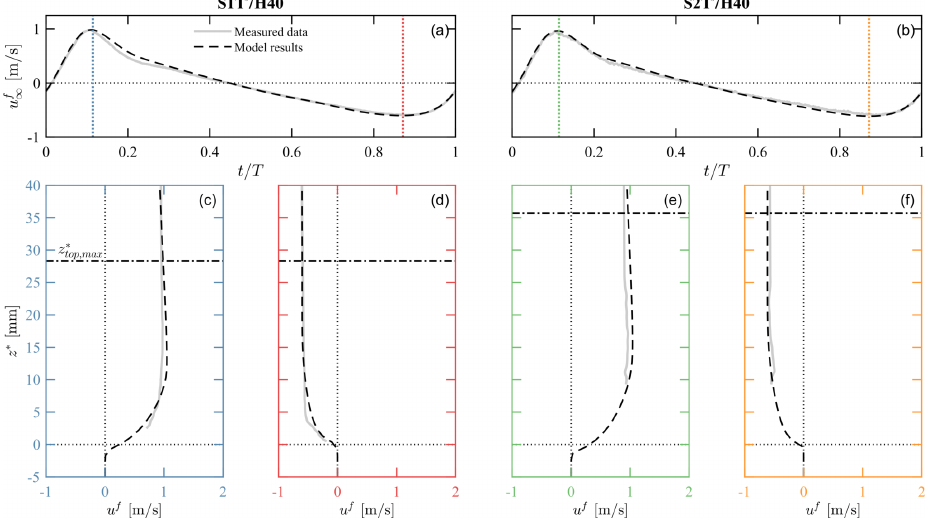
Figure 6. Time series of measured (gray solid curves) and modeled (black dashed curves) free stream velocity, u f ∞ ( t / T ) , for ( a ) S1T7H40 and ( b ) S2T7H40. ( c – f ) are vertical profiles of streamwise fluid velocity, u f ( z ∗ , t / T ) , under ( c , e ) the wave crest ( t / T = 0.114) and ( d , f ) wave trough ( t / T = 0.871), as denoted in ( a , b ) using vertical dotted lines with corresponding colors. Dashed and dotted lines in ( c – f ) represent z ∗ top , max